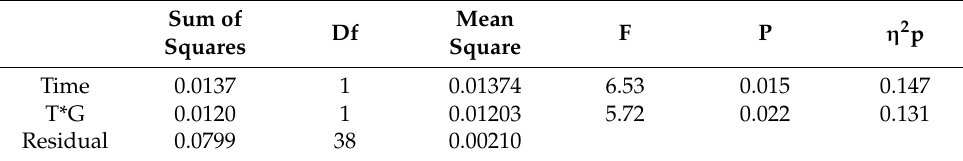
Table 3. Analysis of the Tc parameter within subjects effects.